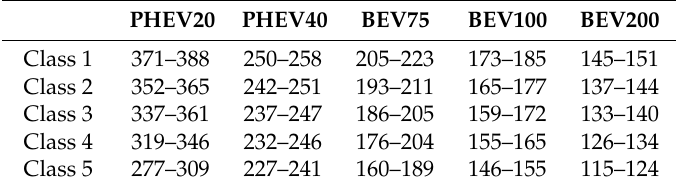
Table 2. Projected pack-level direct manufacturing costs for MY 2025 by vehicle type and range ($/kWh, 2015$).